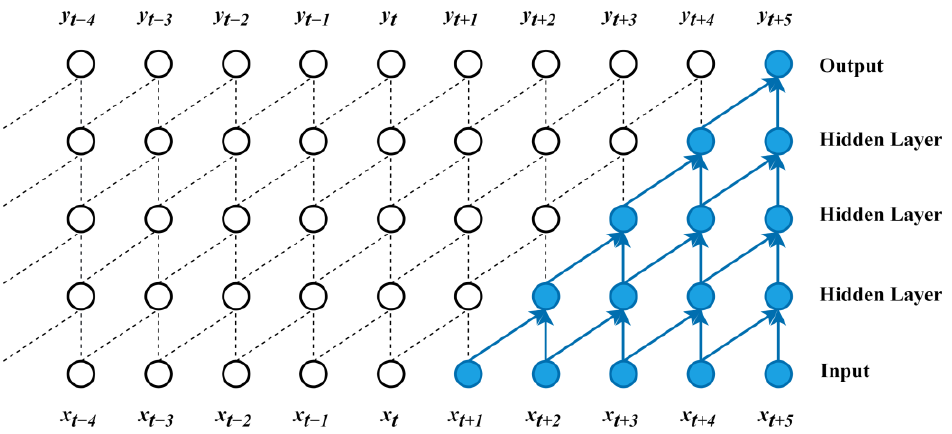
Figure 1. Visualization of a stack of causal convolutional layers.